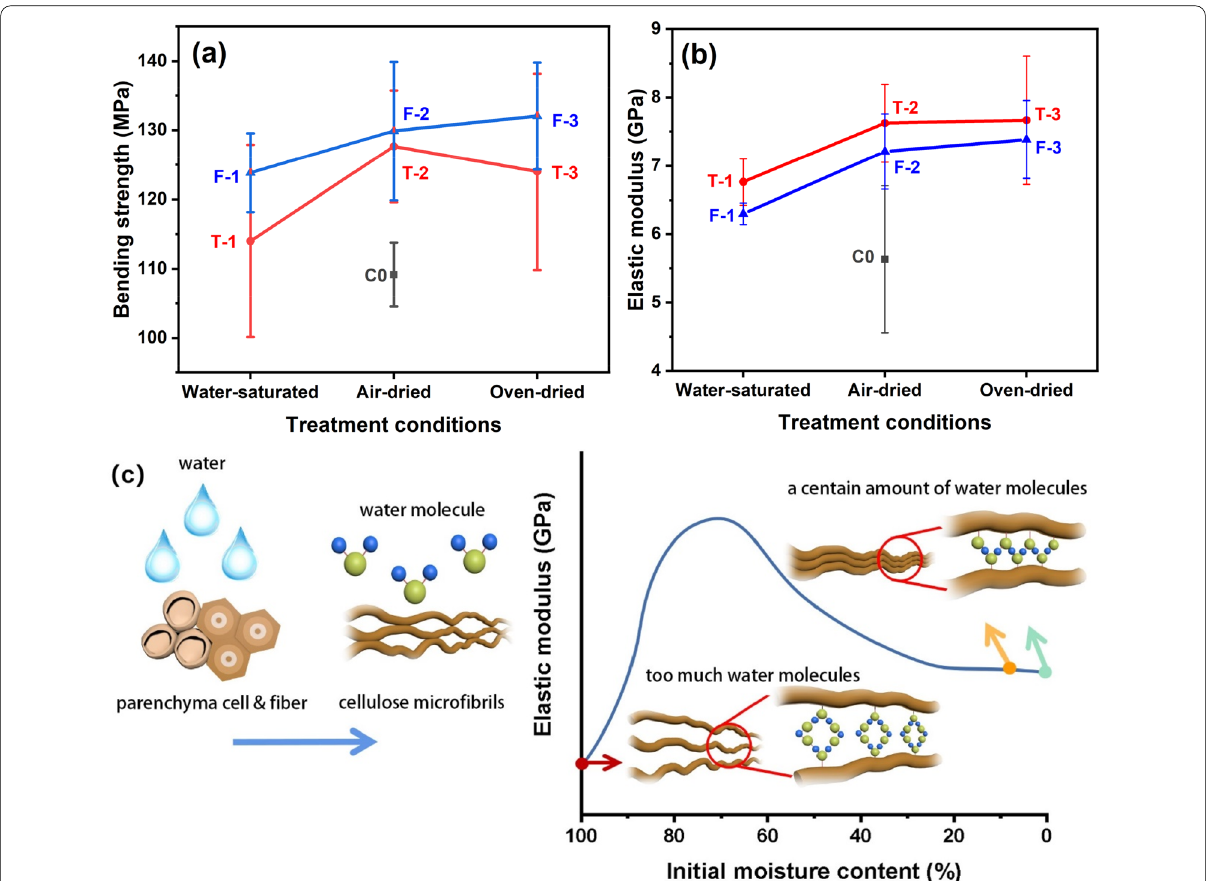
Fig. 5 The change of bending strength and elastic modulus of bamboo after freeze–thaw treatment with different moisture content. ( a bending strength, b elastic modulus, c schematic diagram of water entering cell wall under different moisture contents [23].) (The points are the mean values and the error bars refer to the standard